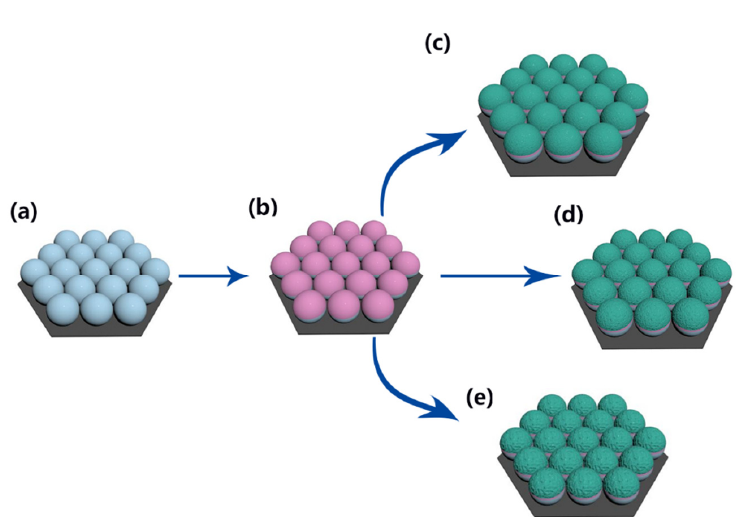
Figure 1. Schematic illustration of Ag and Ag/ZnS film deposition onto a PS array. ( a ) Ordered PS bead array by self-assembly technique; ( b ) Ag film deposition onto PS bead array; ( c – e ) ZnS film deposition with different time.